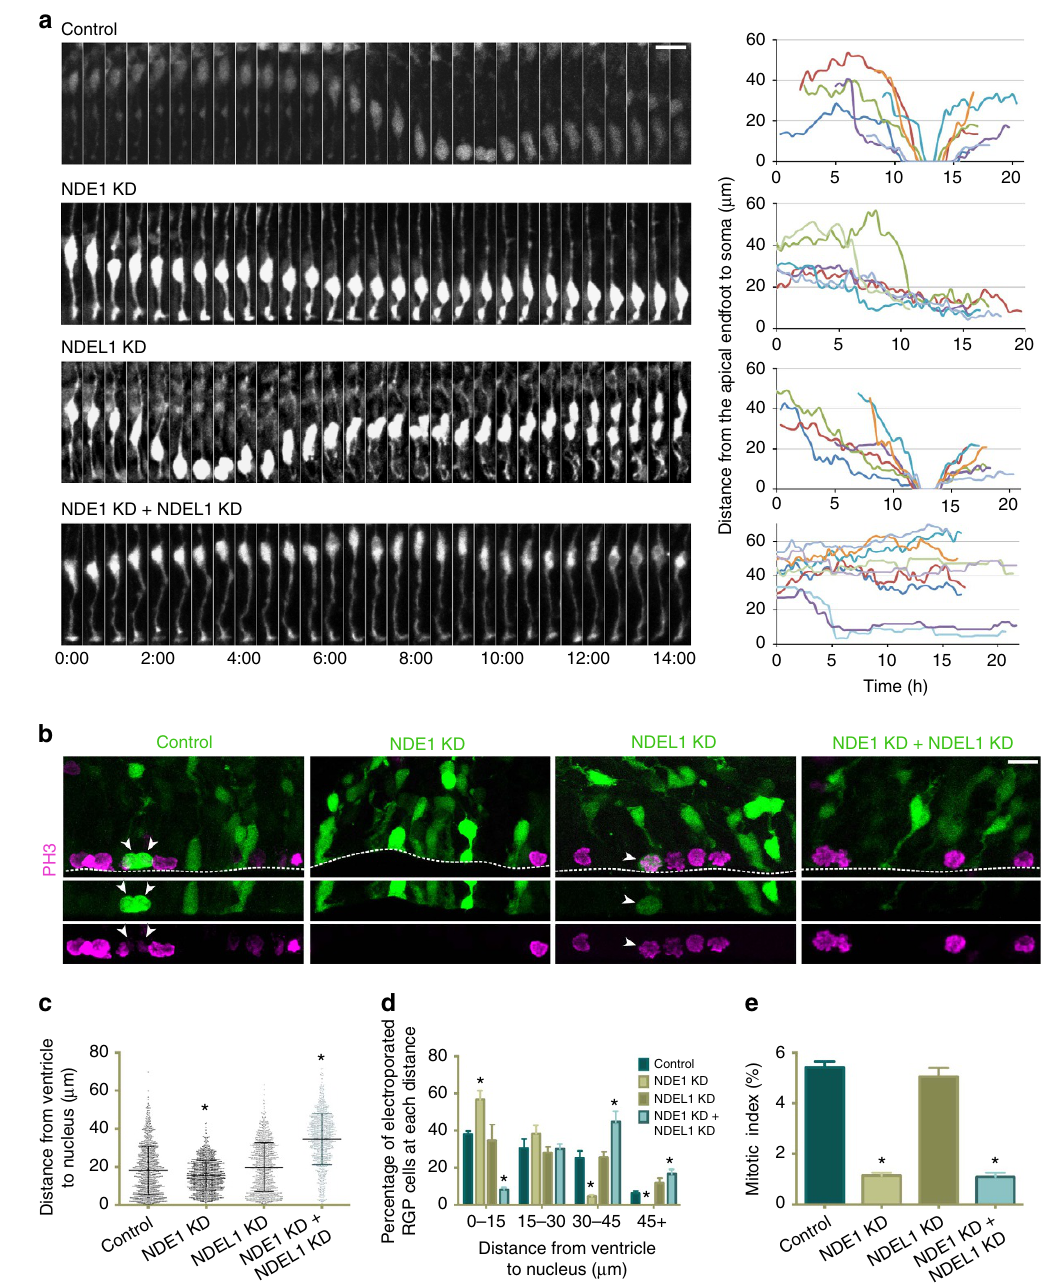
Figure 2 | NDE1 knockdown blocks apical nuclear migration and potently reduces the mitotic index. ( a ) Live-imaging montage of GFP-expressing RGP cells at E19 with a control empty vector expressing GFP alone, or shRNAs to NDE1, NDEL1 or both genes along with a GFP reporter. Representative tracings from multiple RGP cells for each condition are shown at right. Montage panels are shown at 30min intervals (Supplementary Movies 1–4). ( b ) Representative images of the VZ from the electroporated brains stained for the mitotic marker phosphohistone-H3 (PH3). Arrowheads mark soma of PH3 þ /GFP þ RGP cells. Dashed line represents the ventricular surface. ( c , d ) Measurements of the distance between the bottom of the nucleus and the ventricular surface, corresponding to the apical process length, across the various conditions. NDE1 knockdown shifted the apical process length distribution towards shorter distances, with a significant accumulation of RGPs with an apical process of 0–15 m m. NDE1/NDEL1 double knockdown, however, shifted the apical process length distribution to larger distances, with a significant accumulation of RGPs with an apical process of 30–45 m m. Each dot represents an individual apical process length measurement for one electroporated RGP cell. ( e ) Effect of RNAi on RGP cell mitotic index, measured as the number of electroporated RGP cells positive for PH3 divided by the total number of electroporated RGP cells. All mitotic figures of RGP cells were located at the ventricular surface, and NDE1 knockdown, as well as NDE1/NDEL1 double knockdown, caused a strong reduction in the mitotic index. Data presented as scatterplot in c with bars representing the median ± the interquartile range, and as mean ± s.e.m. in d and e . Kolmogorov–Smirnov test for non-parametric distributions used in c (* P o 0.05, n ¼ 1,012–1,073 RGP cells). Unpaired t -test used in d and e (* P o 0.05, n ¼ 3 embryonic brains from different mothers). Scale bar, 10 m